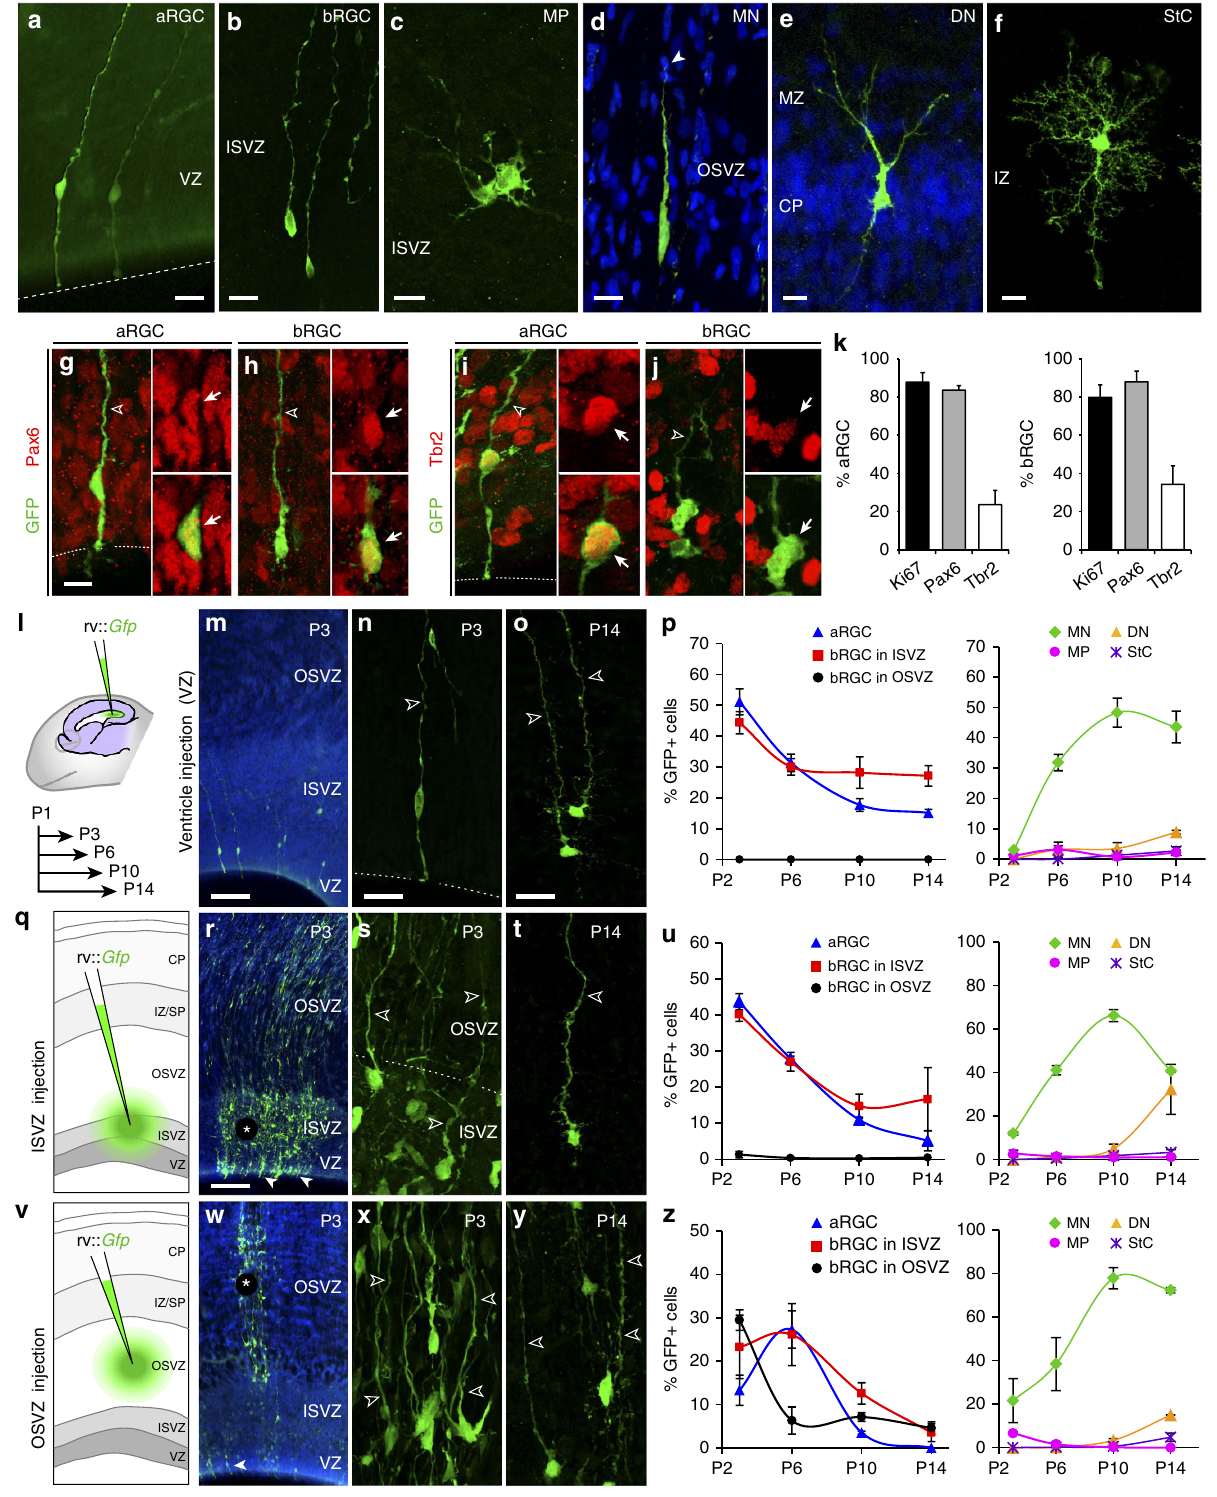
NATURE COMMUNICATIONS|7:11812|DOI: